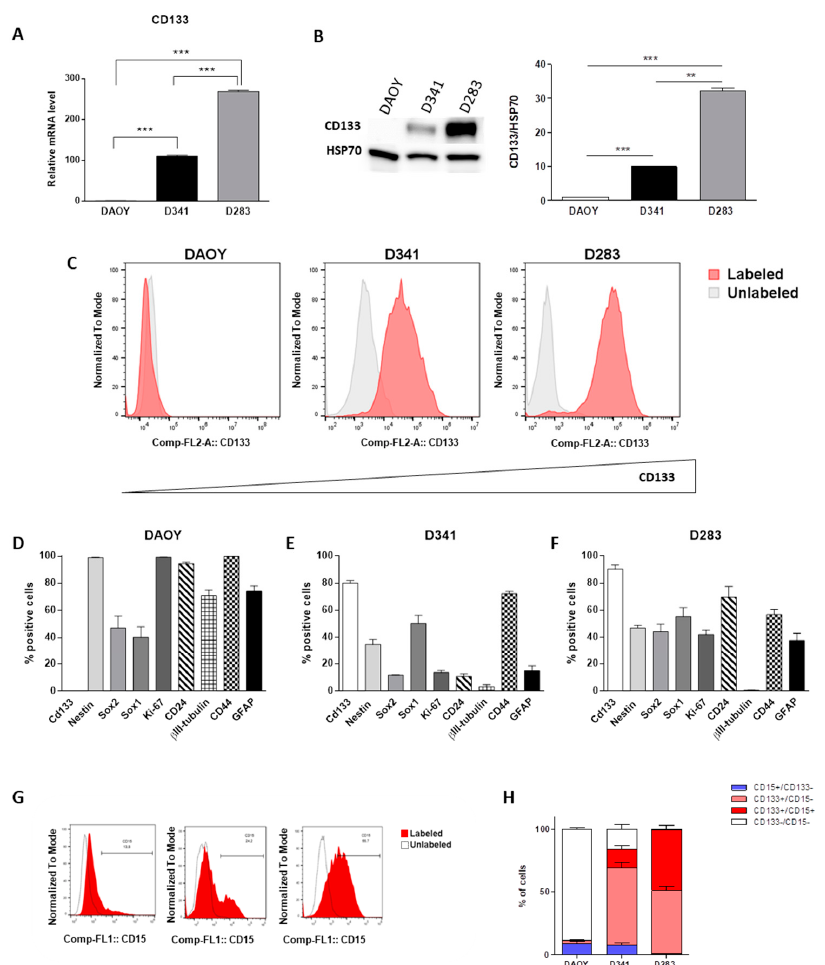
Figure 1. Evaluation of multiple stemness markers in parental medulloblastoma (MB) cells. Gene ( A ) and protein expression of CD133 by Western blot ( B ); band intensities were normalized against HSP70, and DAOY expression level was taken as 1) and flow cytometry analysis. Whole western